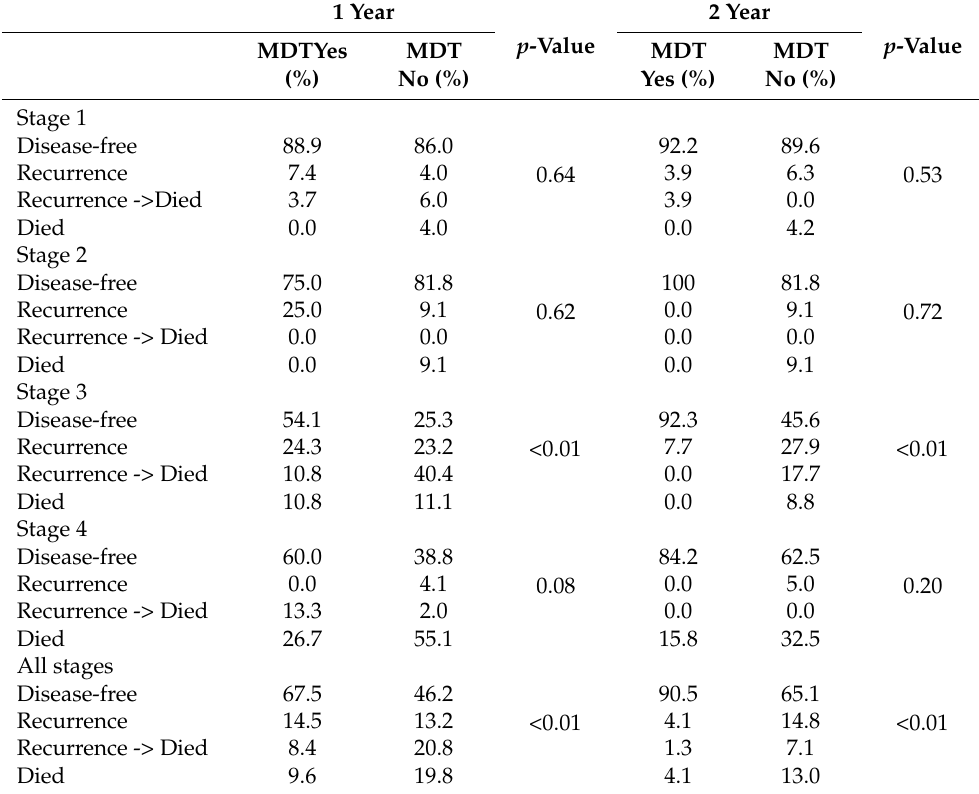
Table 4. Distribution of outcomes by stage for MDT and non-MDT patients, one and two years after